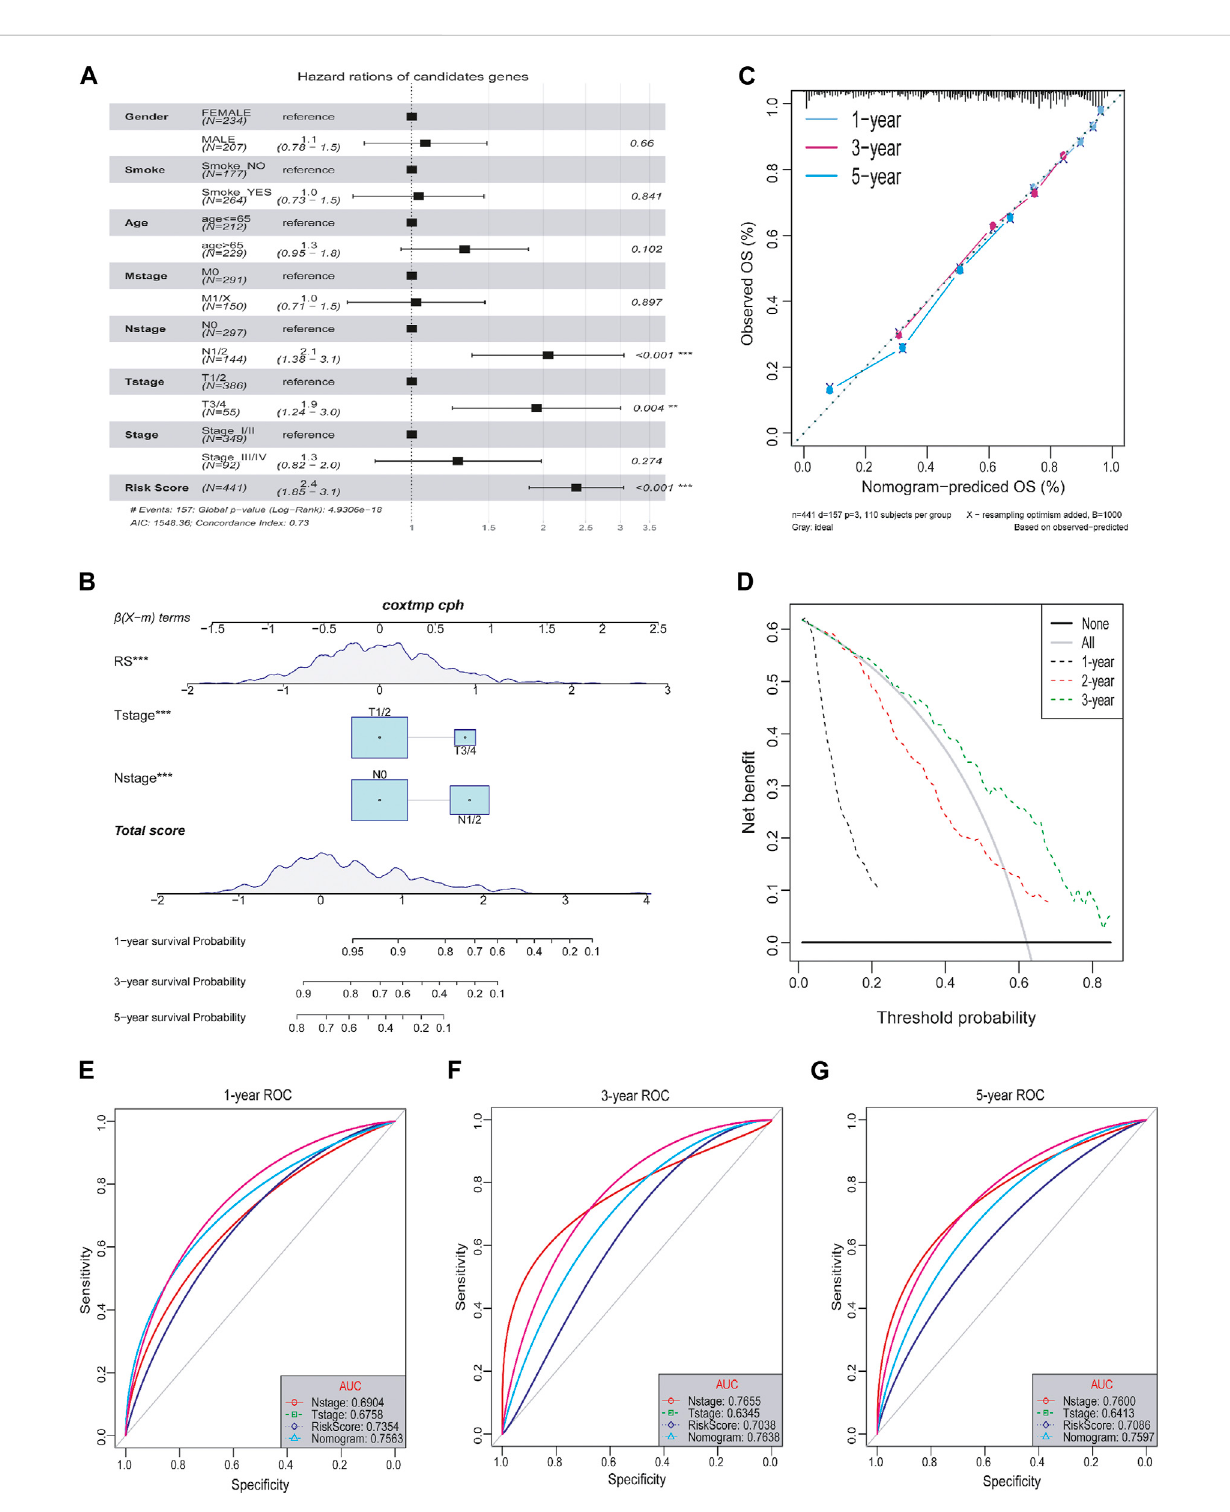
FIGURE 8 Relationship between tumor risk score and clinical characteristics. (A) Multivariate cox analysis of clinical characteristics and risk score. (B) Nomograms of clinical characteristics and risk score. (C) Calibration charts of nomograms in 1-, 3-, and 5-year. (D) DCA distribution map of nomograms in 1-, 3-, and 5-year. (E – G) ROC curves in 1-, 3-, and